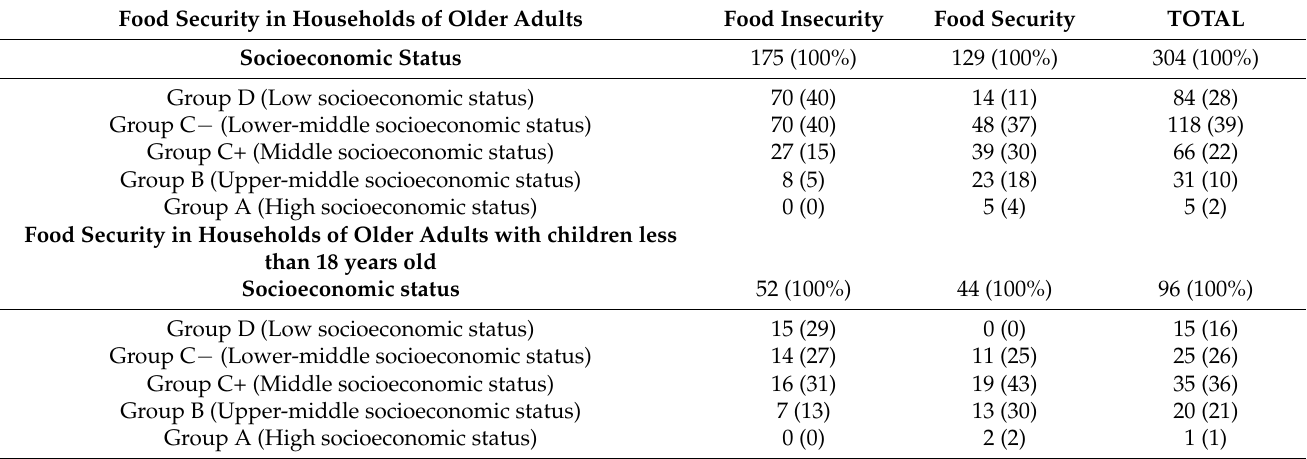
Table 4. Socioeconomic status and food insecurity of older adults by household type.